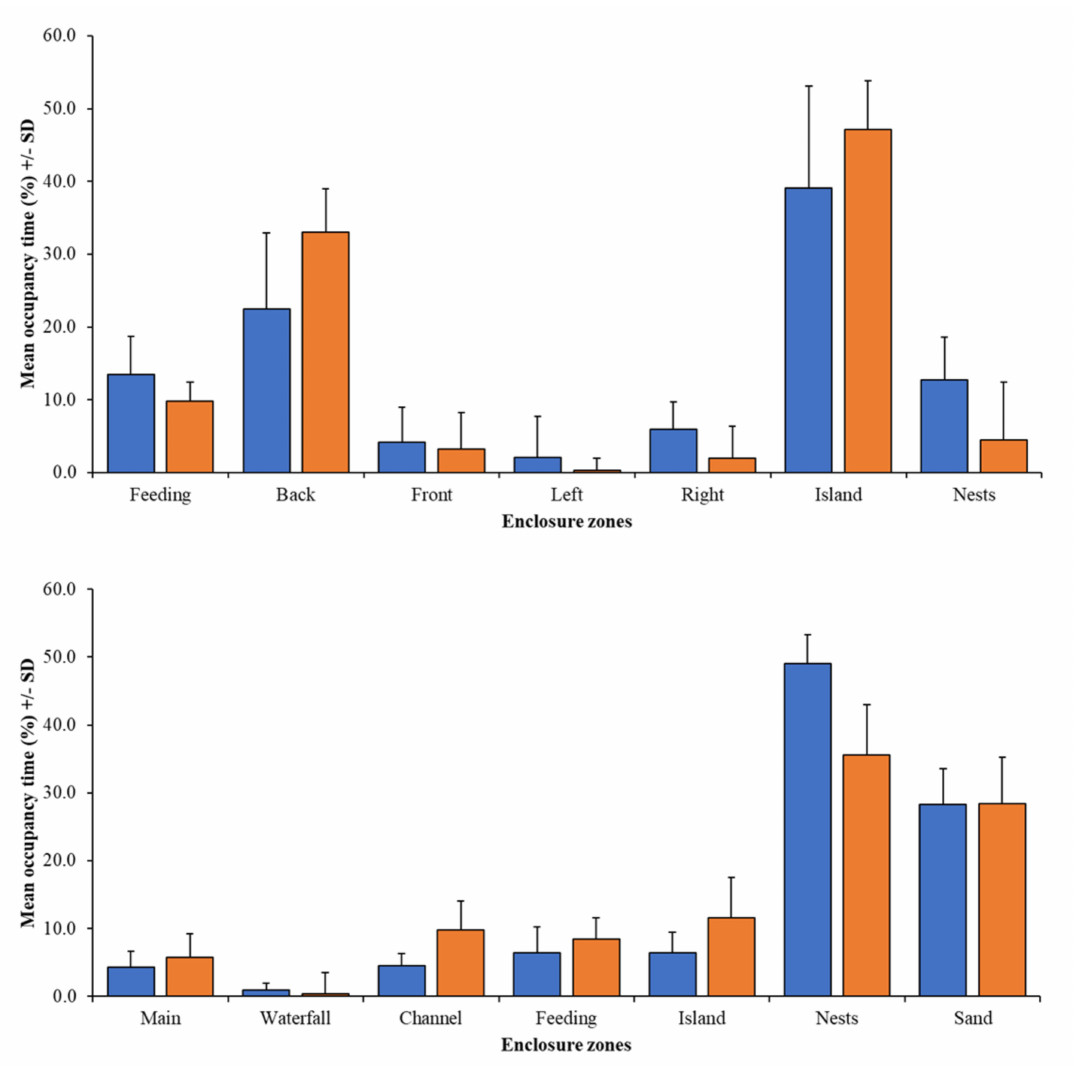
Figure 7. Comparison of time seen within each zone for group data (blue bars) and individual data (orange bars) for PZ flamingos ( top ) and BZ flamingos ( bottom ). Table 1. Time of day compared to sum of individuals/time per individual within each zone for the PZ and BZ flamingo flocks. Shaded cells indicate the largest number of birds seen in a zone at that observation time and the maximum amount of time spent within a zone by an individual